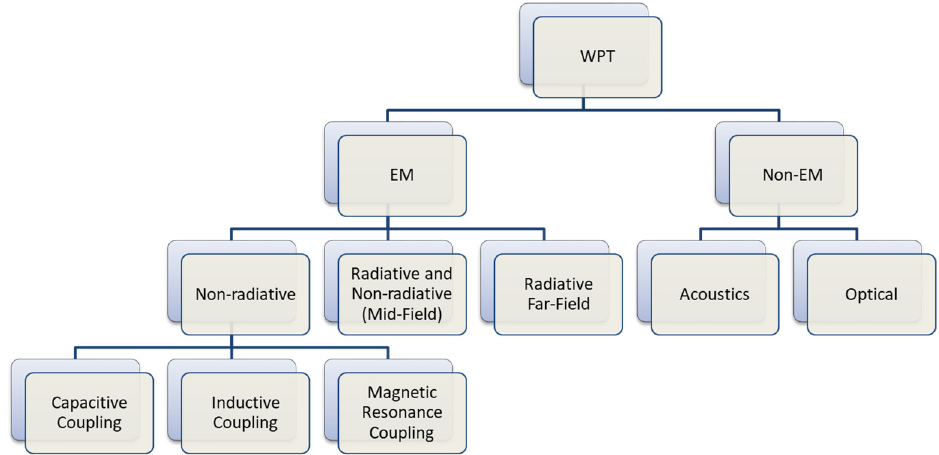
Figure 6. Different wireless power transfer techniques.